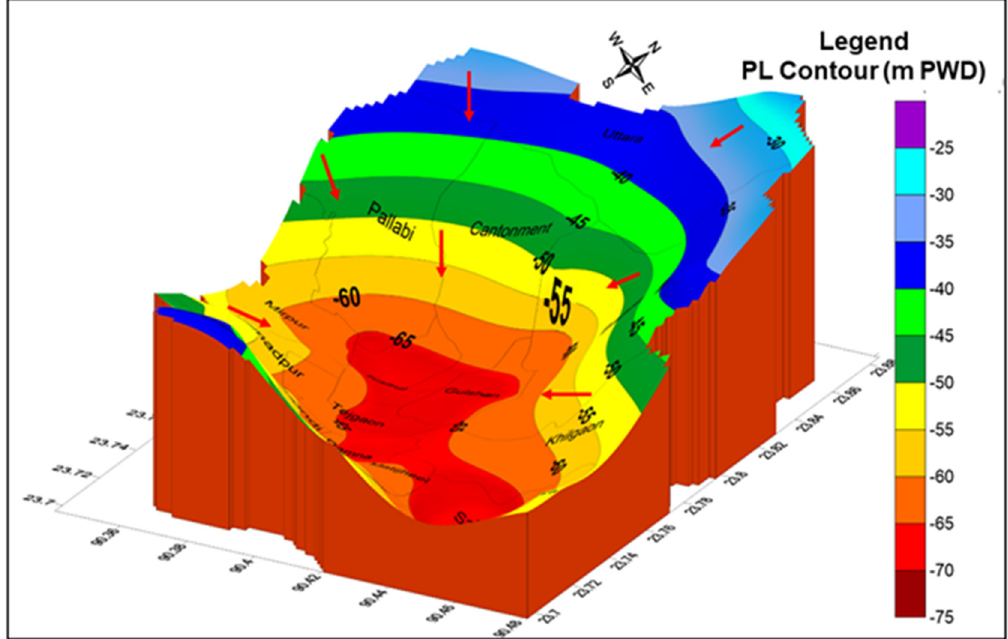
Figure 16. Three-dimensional PL elevation model with water flow directions for 2018 in MDA in Dhaka city.